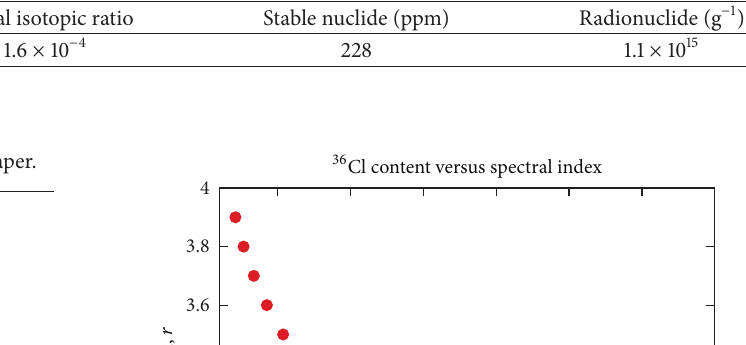
Table 1: Characteristics of 36 Cl found in CAIs.